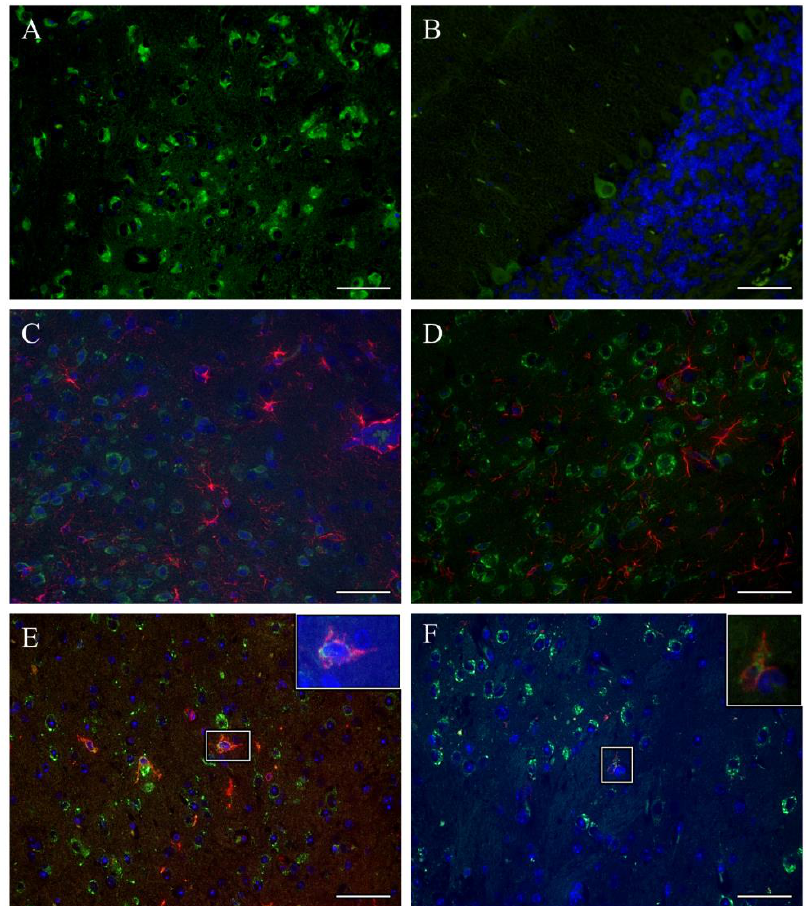
Figure 3. Immunofluorescence determined the cellular targets of TBEV infection in brain. Brain slices were stained using antibody targeting TBEV E-protein (green) and Hoechst (nuclei, blue). Representative images from thalamus ( A ) and cerebellum ( B ) show infected cells that morphologically resemble neurons. Double labeling of TBEV E-protein (green) and glial fibrillary acid protein (GFAP, astrocytes; red) of hypothalamus ( C ) and cerebral cortex ( D ) shows no colocalization of TBEV antigen with astrocytes. Costainings with anti-Iba-1 (microglia/macrophages marker; red) and TBEV E-protein (green) show mostly uninfected microglia/macrophages. However, few Iba-1 + TBEV + cells were detected in the midbrain ( E ) and thalamus ( F ) of mock immunized and TBEV-Hypr infected mice. Scale bars 50 µm.